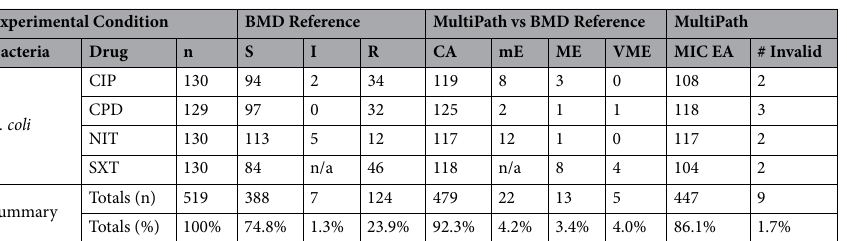
Table 5. MultiPath AST accuracy vs BMD reference method for clinical specimens positive for E. coli . Four antibiotics were tested: ciprofloxacin (CIP), cefpodoxime (CPD), nitrofurantoin (NIT) and trimethoprim/ sulfamethoxazole (SXT). AST categorical results are shown for the BMD reference method and agreement by the MultiPath method. Abbreviations and calculations of ME and VME percentages are as described in Table 4. MIC essential agreement (EA) and number of invalid MultiPath results are also